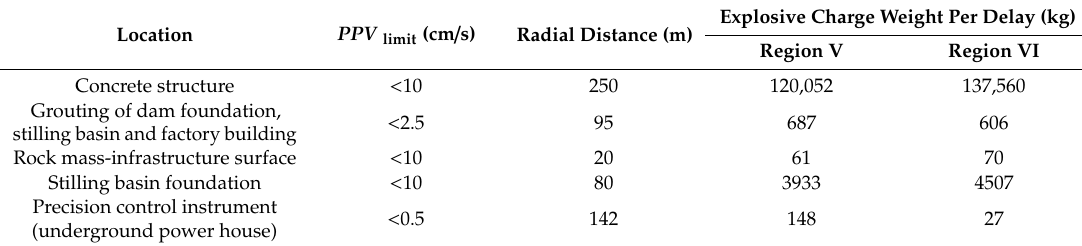
Table 3. Permissible blast vibration values of hydropower station.